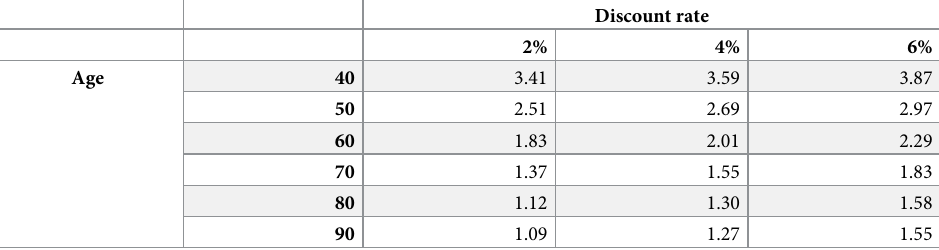
Table 3. Predicted marginal ratio of QALYs lost from ICH, relative to ischemic stroke, at selected ages and dis- count